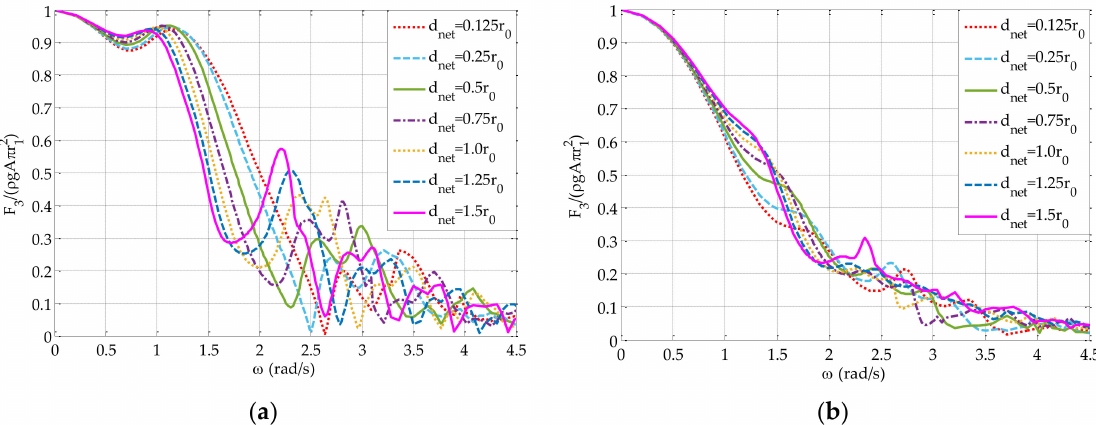
Figure 5. Effect of d net on the non-dimensional heave exciting forces applied on the oblate spheroidal WECs placed around the monopile for β = 0 o : ( a ) WEC1 and WEC4; ( b ) WEC2 and